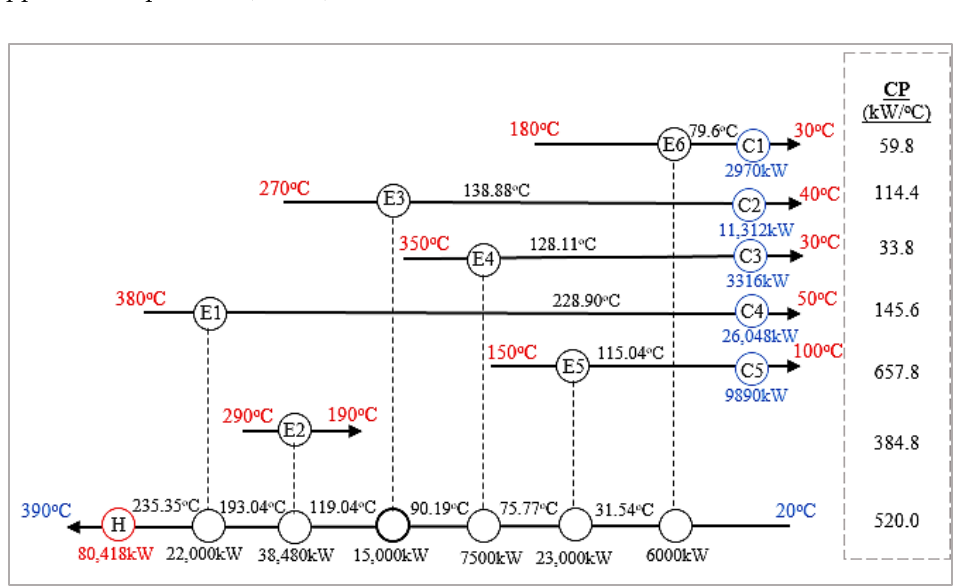
Figure 1. Existing HEN of refinery pre-heat train.